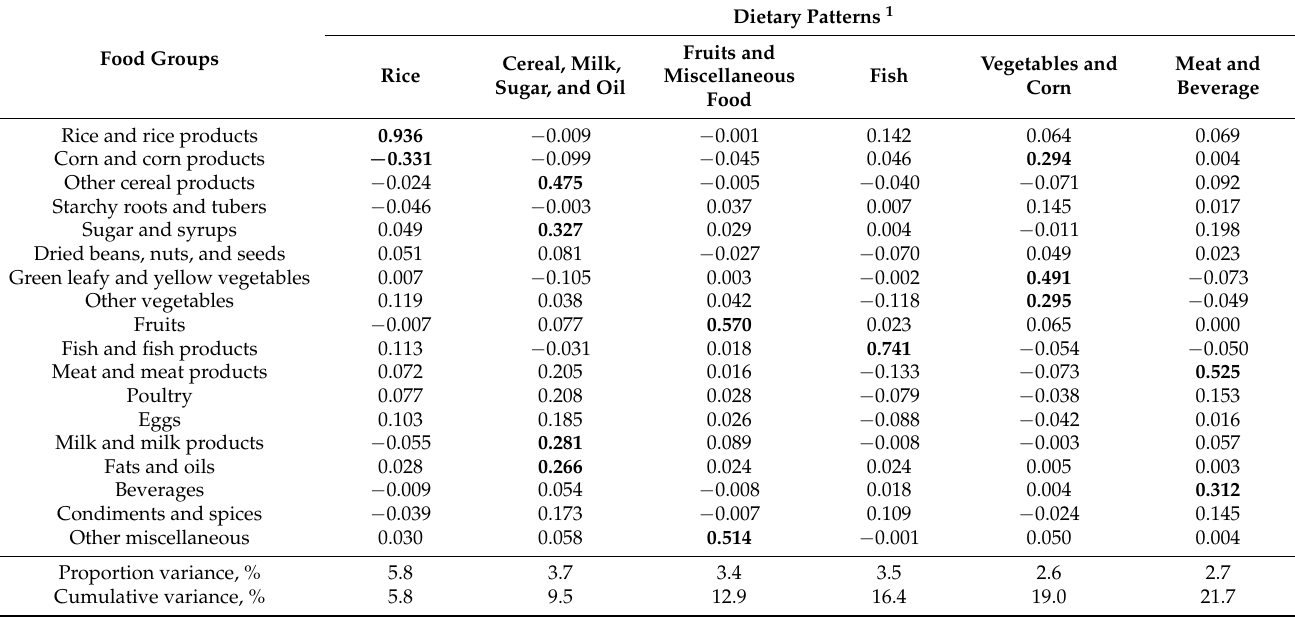
Table 3. Factor loadings for the six identified dietary